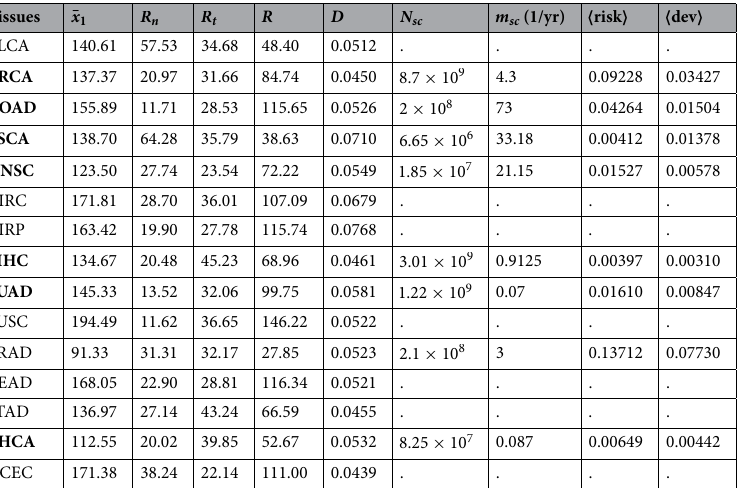
Table 2. A set of parameters compiled for a group of tumors. The geometry of the normal and tumor x 1 , R n and R t come from Ref. 10 . The minimal distance between both regions is regions, i.e. the parameters ¯ R x 1 R n R t . The D value is estimated as the maximum of = ¯ − − stem cells, N sc and the stem cell turnover rate, m sc , are borrowed from Refs. 27,28 . The lifetime risk of cancer and its deviation (when available) is computed from Ref. 28 as the mean value and the standard deviation of the cumulative risk at a maximum age of 80 years. Bold marked tissues correspond to cancer types for which all the data is available.